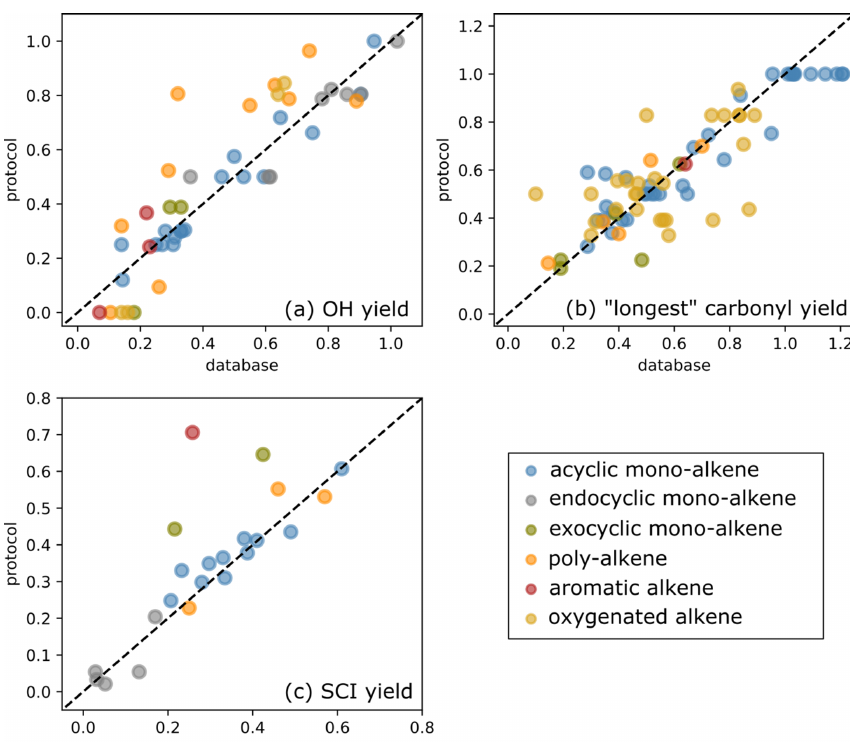
Figure 11. Scatter plot of protocol yields vs. database yields: (a) OH yields, (b) yields for the “longest” carbonyl and (c) SCI yields.